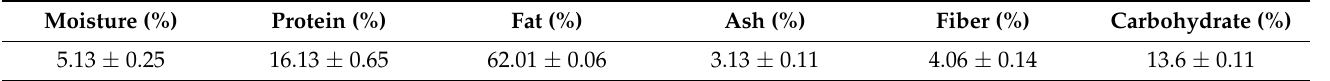
Table 1. Nutritional content of uncoated fresh almond